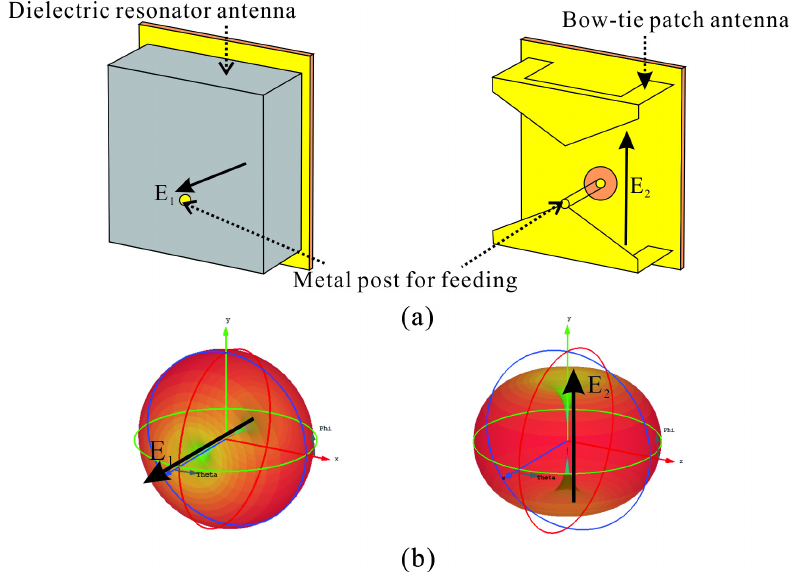
Figure 2. Concept of the quasi-isotropic pattern: ( a ) direction of field; ( b ) three-dimensional radiation